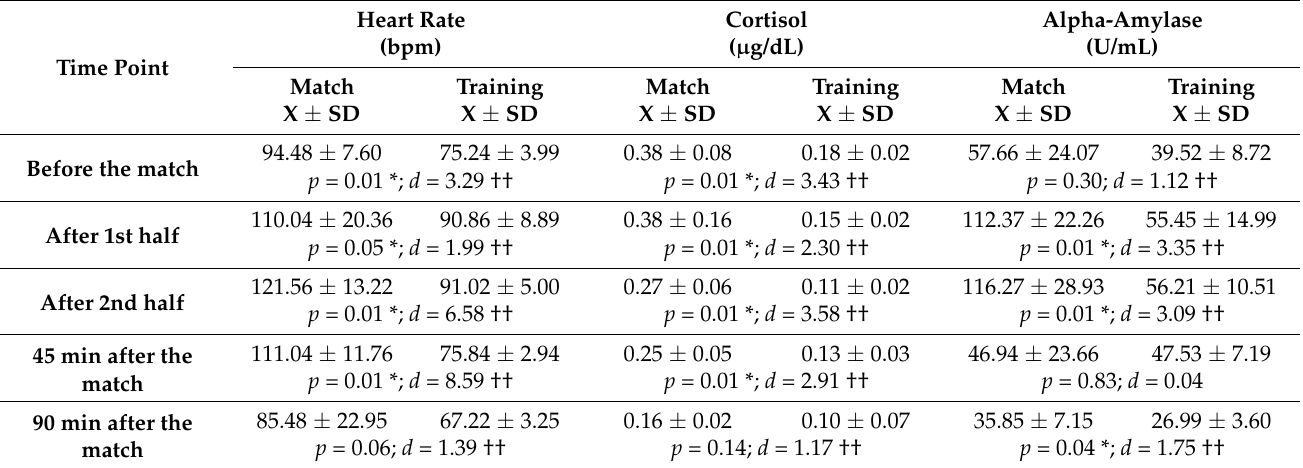
Table 1. Differences between matches and training sessions; results calculated by Mann–Whitney U test and magnitude of differences presented as Cohen’s d .